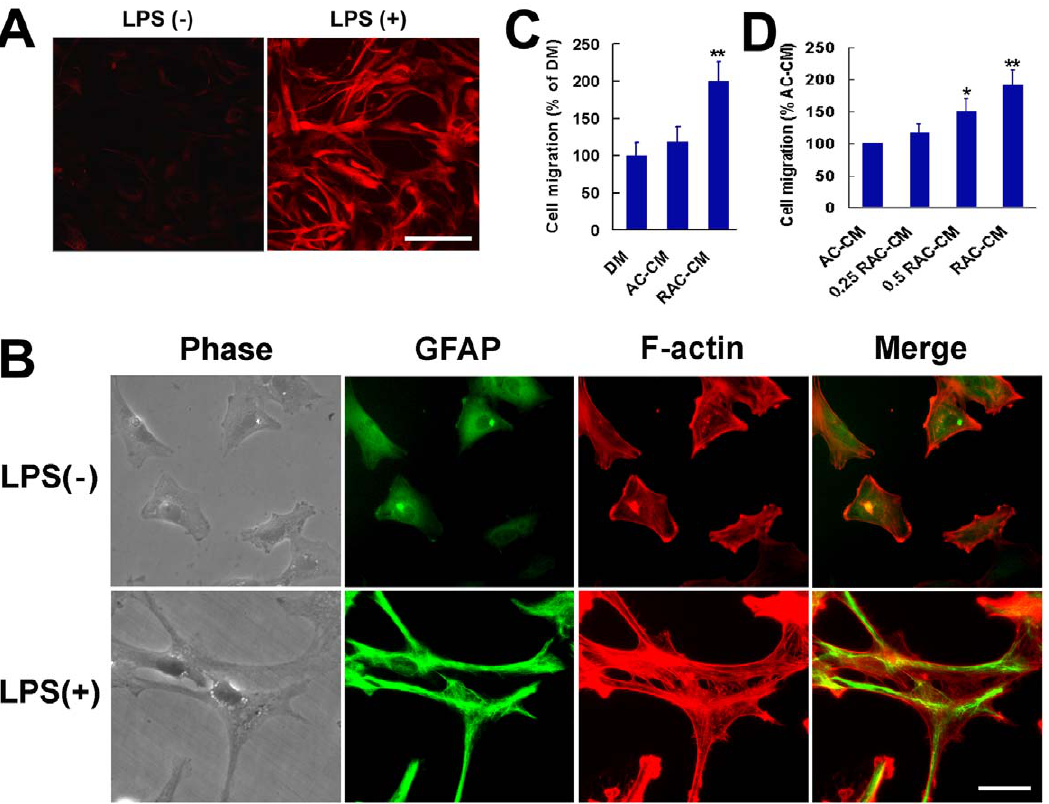
Figure 2. Reactive astrocytes-conditioned medium promotes OECs migration. (A, B) lipopolysaccharide (LPS) stimulates astrocytes to change into reactive astrocytes. After incubation with LPS (10 m g/mL) for 24 hr, astrocytes are activated to express nestin (A) and undergo an extensive hypertrophy of their cell bodies and cytoplasmic processes and a massive up-regulation of GFAP (B). Scale bars: 50 m m (A); 25 m m (B). (C) Reactive astrocyte-conditioned medium (RAC-CM) promotes OECs migration. After stimulation with defined medium (DM), astrocyte-conditioned medium (AC-CM) or RAC-CM for 8 hr, the migrating cells in the Boyden chambers are stained with Coomassie Brilliant Blue and counted. ** P , 0.01 versus DM. (D) Enhancement of migration of OECs by RAC-CM is dose-dependent. * P , 0.05 versus AC-CM, ** P , 0.01 versus AC-CM.